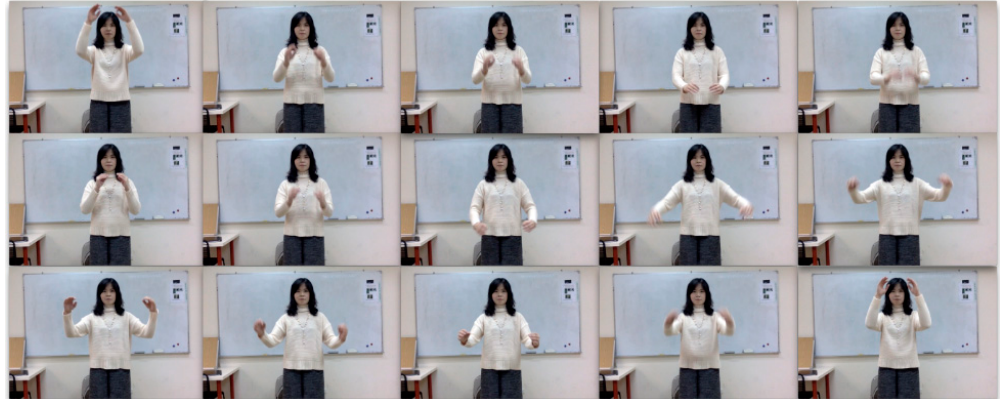
Figure 12. Examples of a triple (3/4) gesture.